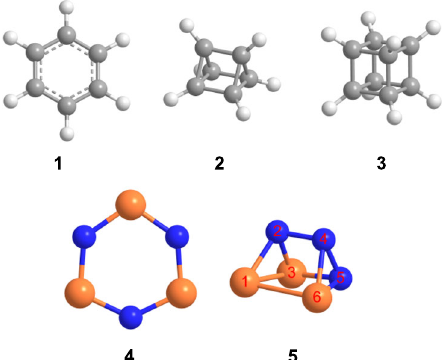
Fig. 1 Molecular structures of representative C 6 H 6 , C 8 H 8 , and P 3 N 3 isomers. 1 , benzene (C 6 H 6 , D 6h ); 2 , tetracyclo[2.2.0.0 2,6 .0 3,5 ]hexane (prismane, C 6 H 6 , D 3h ); 3 , pentacyclo[4.2.0.0 2,5 .0 3,8 .0 4,7 ]octane (cubane, C 8 H 8 , O h ); 4 , cyclotriphosphazene (P 3 N 3 , D 3h ); 5 , 1,2,3-triaza-4,5,6- triphosphatetracyclo [2.2.0.0 2,6 .0 3,5 ] hexane (P 3 N 3 , C 1 ) (see “ Methods: Theoretical ” ). The atoms are color coded in gray (carbon), white (hydrogen), blue (nitrogen), and orange